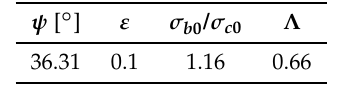
Table 1. Plastic flow